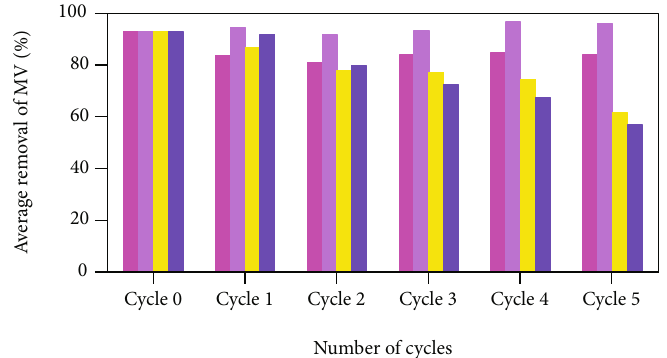
Figure 7: Regeneration studies of NaOH-KR spent on adsorption of MV for 5 consecutive cycles with acid (pink bar), base (purple bar), water (yellow bar), and control experiment (blue bar) (mass of adsorbent = 0 : 020 g; concentration of MV = 100 mgL -1 ).